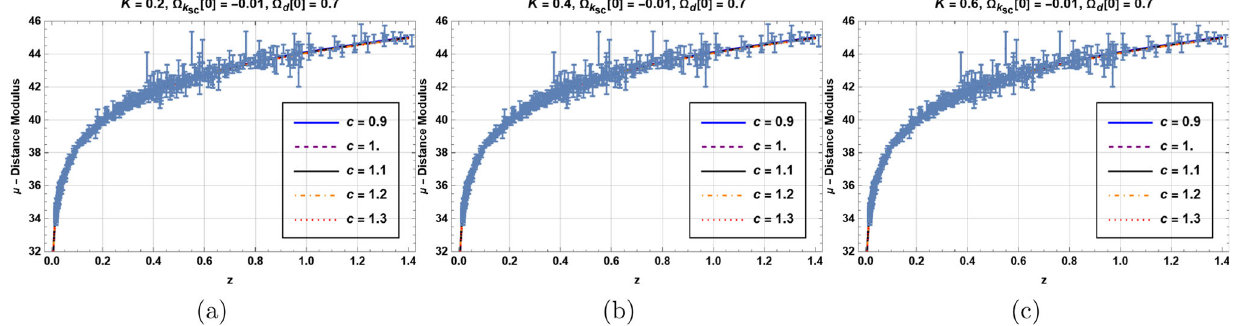
[ 0 ] = 0 . 7. Bars display the 580 Union 2.1 scores along with the (cid:2) d SNIa results from the distance modulus data